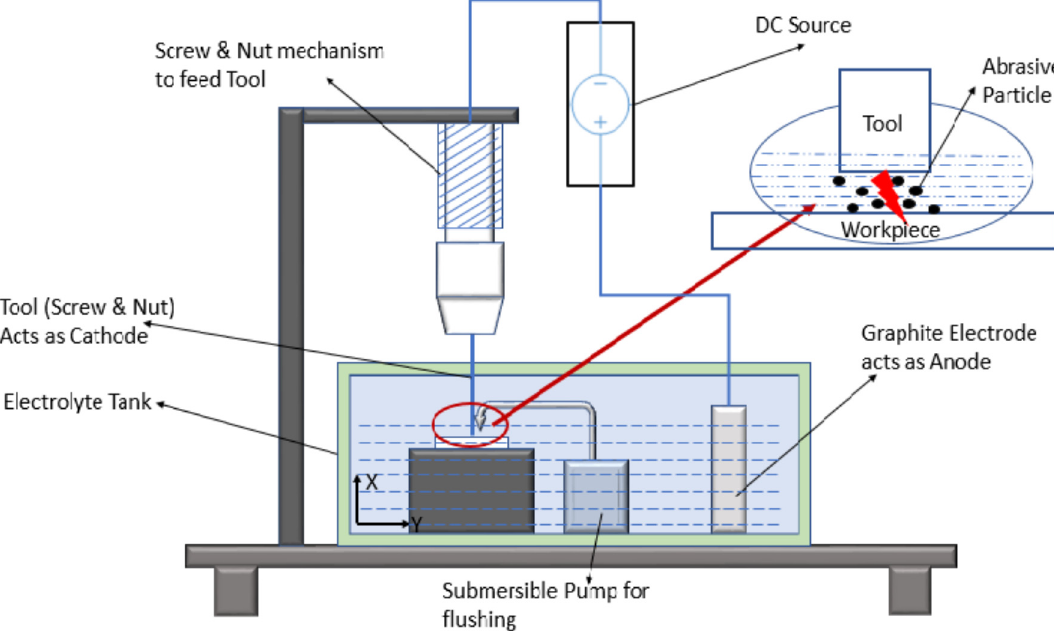
Fig. 1. Electro Chemical Discharge machining setup with power